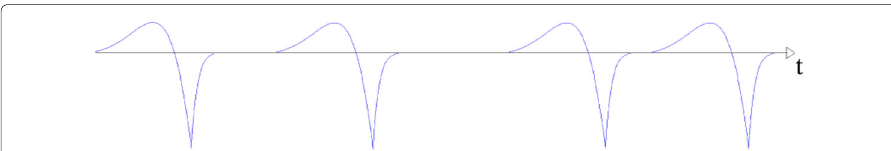
Fig. 9 Example of glottal flux obtained after the convolution of the cyclostationary impulse train with the derivative of the impulse response of the Liljencrants-Fant glottal